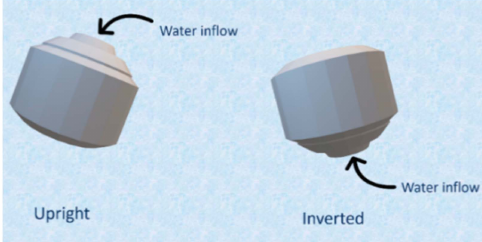
Figure 6. Floating mechanism of optimized formulation. The internal structure of tablet is composed of a grid infill with void space filled with air so that the tablet has low density, which helps in buoyancy of the tablet in